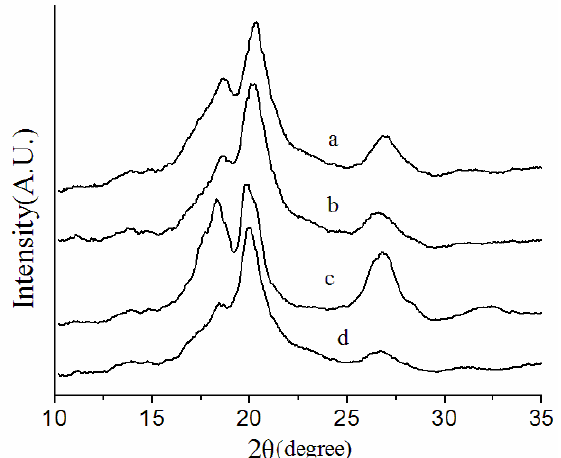
Figure 4. XRD patterns of solution-cast membranes prepared at different